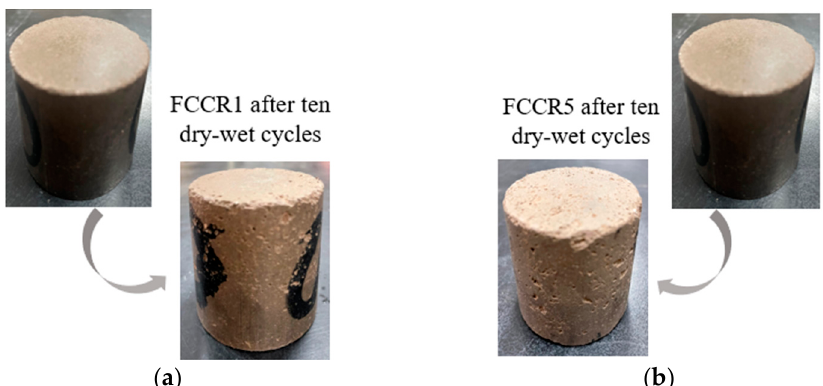
Figure 8. Surface features of FCCR after ten w-d cycles: ( a ) FCCR1 and ( b ) FCCR5. Figure 9 represents the variation in the mass loss rate of FCCR with d-w cycles. From